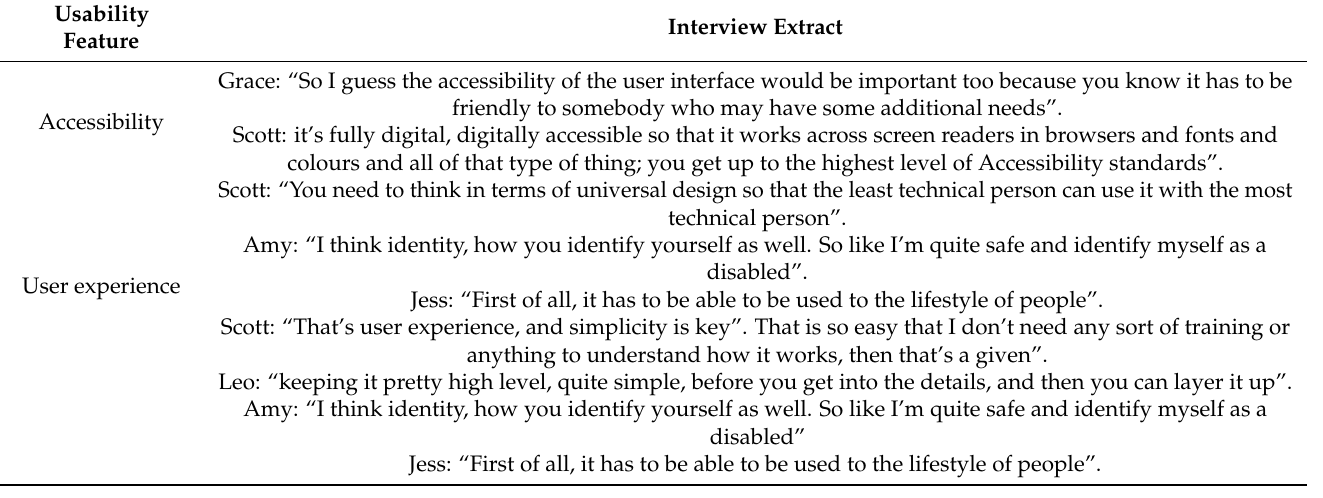
Table 4. AT Passport usability features.